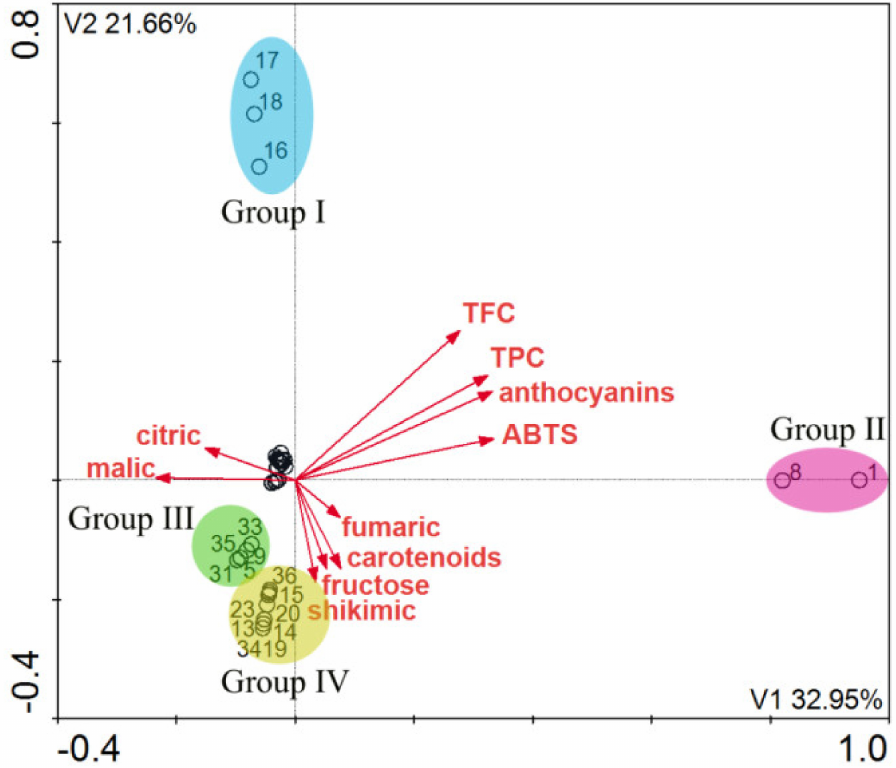
Figure 4. DCA ( n = 38) A diagram showing the distribution of the elderberry extract samples in terms of the antioxidative activity and the content of organic acids, pigments, and sugars. Four homogeneous groups were